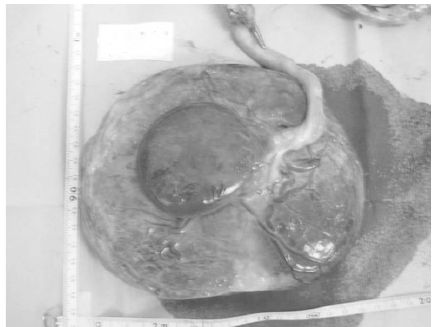
Figure 3: Ultrasonographic image showing subamniotic hematoma at 27 weeks in Case